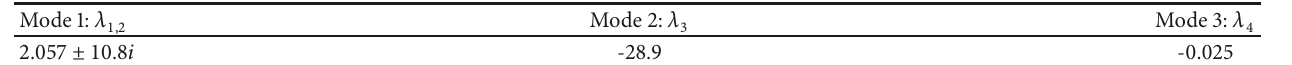
Table 2: Eigenvalues of the system